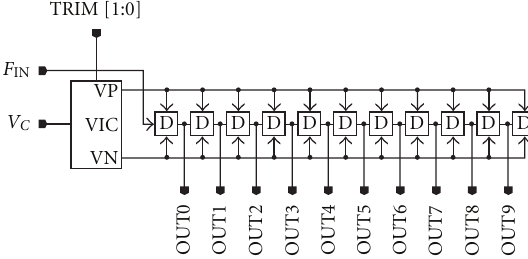
Figure 12: Block diagram of VCDL in DLL1 and DLL3.